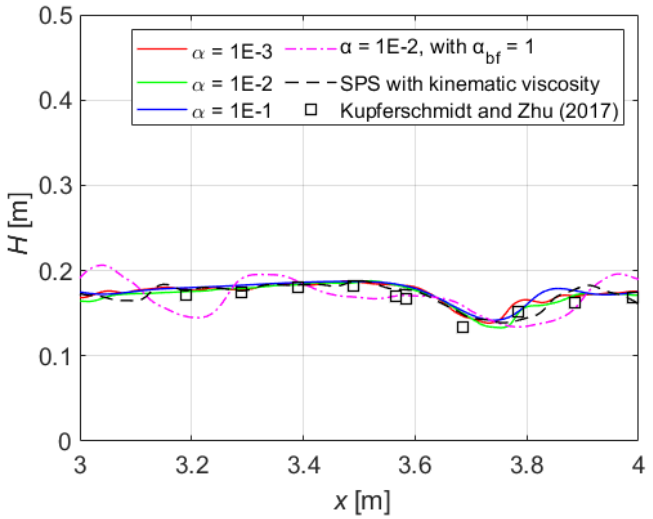
Figure 5. Centerline water-surface elevation along the selected section of HOR case for dp = 1.5 cm and various viscosity treatments.